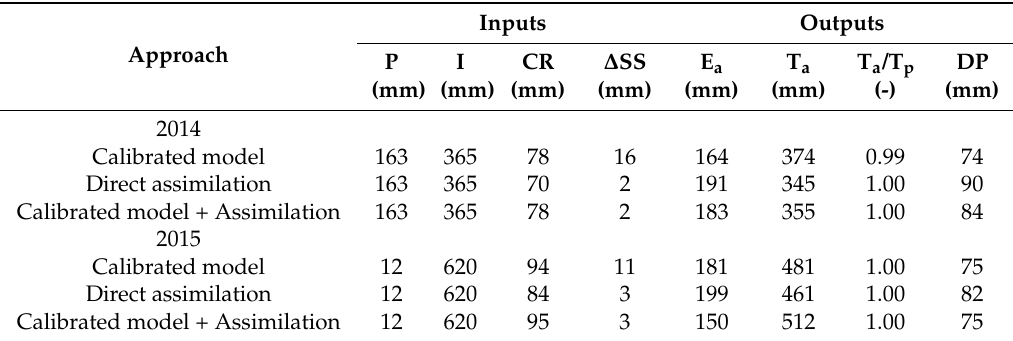
Figure 5. Measured and simulated soil water contents ( θ ) at depths of 10 ( top ), 30 ( middle ) and 50 cm ( bottom ) during 2014 ( left ) and 2015 ( right ) crop seasons. Vertical bars correspond to the standard deviation of measured data. Table 7. Components of the soil water balance.